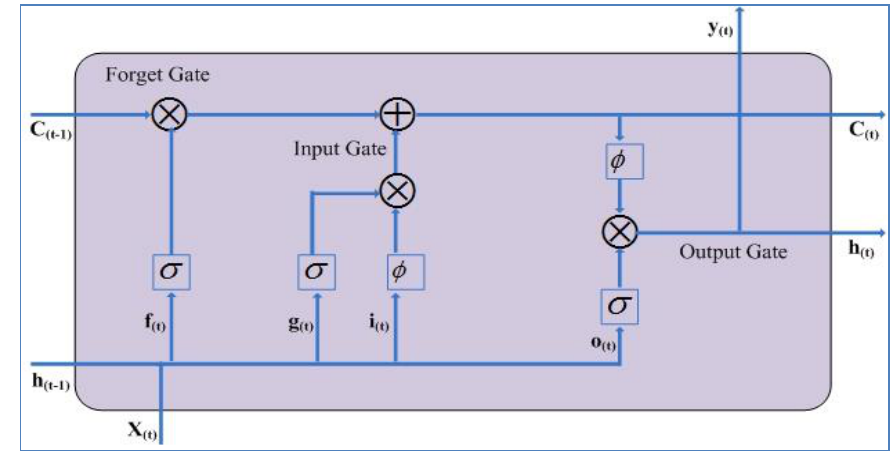
Figure 4. Long short term memory (LSTM) architecture.